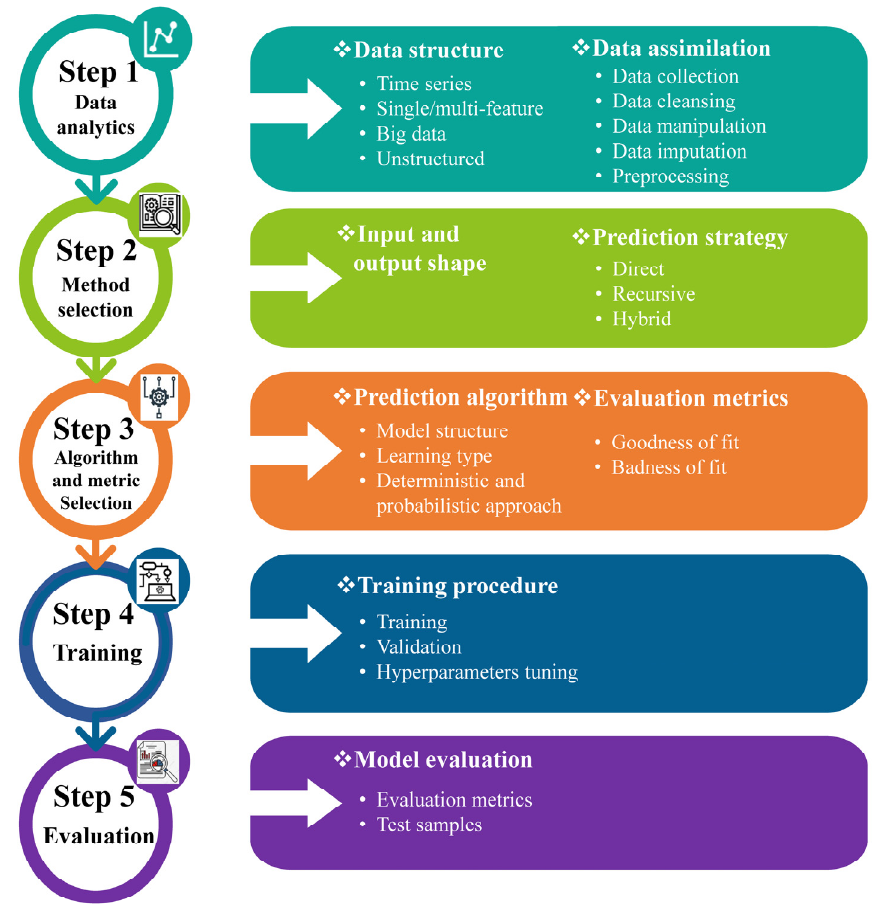
Figure 3. Steps of machine learning–based prediction strategies.